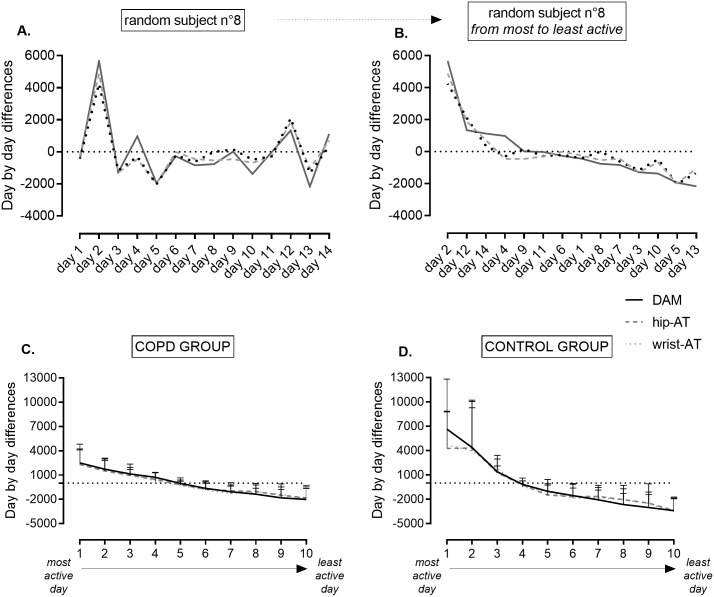
Graphical representation of day-by-day variability in PA, expressed as steps per day around the individual mean PA.Panel A: day-by-day differences around the mean step count of one random patient, recorded by hip-AT, wrist-AT and DAM. Horizontal dotted line represents the mean step count, positive numbers representing more active days as compared to the mean PA measured, negative numbers presenting less active days as compared to the mean PA. Panel B: Individual data (1 random patient) of panel A were ranked from the most active day to the least active day according to DAM. Corresponding data of hip-AT and wrist-AT were added. Finally, after ranking the data for every individual subject, mean (±SD) were calculated for the COPD group and healthy control group. Pooled data are represented in panel C (COPD group) and panel D (control group). Hip-AT = Fitbit Zip; wrist-AT = Fitbit Alta; DAM = Dynaport Movemonitor.